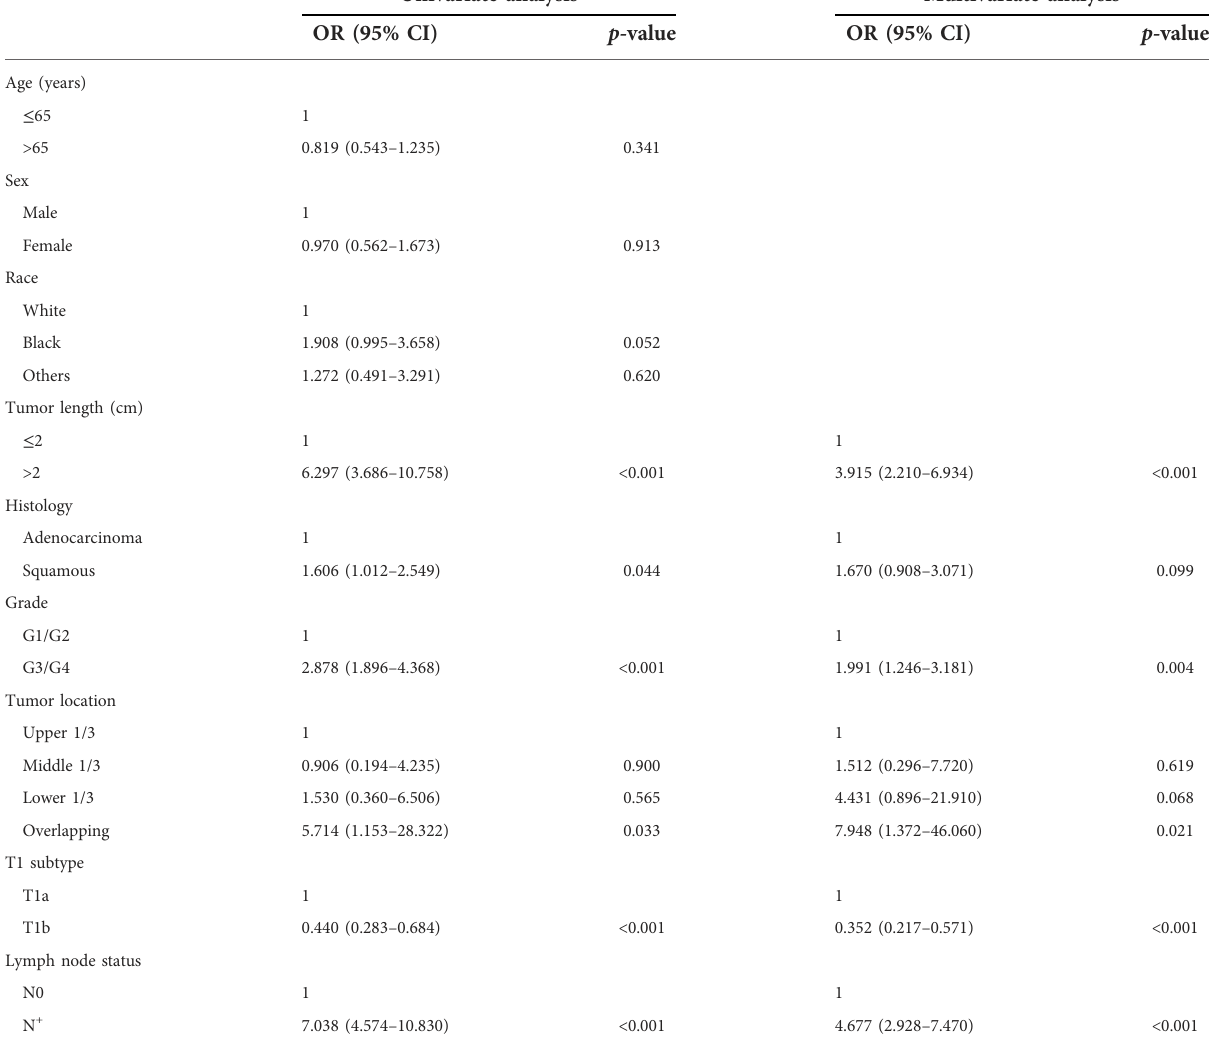
Supplementary Table S2 . For example, a patient was assessed under endoscopy ultrasound (EUS) in which the tumor was located in the lower 1/3 of the esophagus with a tumor length of 5 cm, T stage was T1a, and pathological biopsy indicated poor differentiation. In addition, imaging showed the presence of lymph node metastasis. According to the nomogram, the following scores were obtained: 62 for the lower 1/3 of the esophagus, 78 for tumor length >2 cm, 60 for T1a, 38 for poor differentiation, and 87 for N + . The total of 325 points corresponds to an approximately 52% chance of DM.